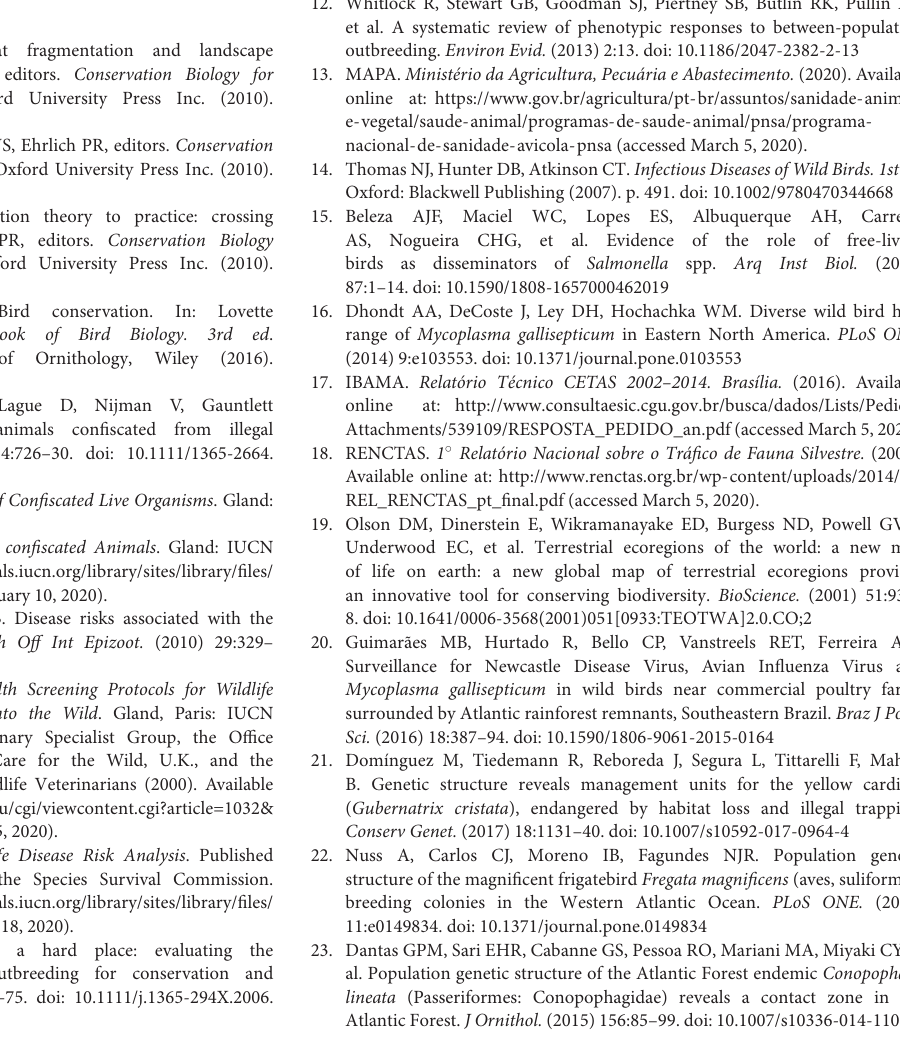
Supplementary Figure 1 | Bayesian skyline plot for both species. Supplementary Table 1 | Dataset free-living passerines. Supplementary Table 2 | Health-related test results for free-living and confiscated passerines. Supplementary Table 3 | Dataset genetic samples. Supplementary Table 4 | Genetic diversity